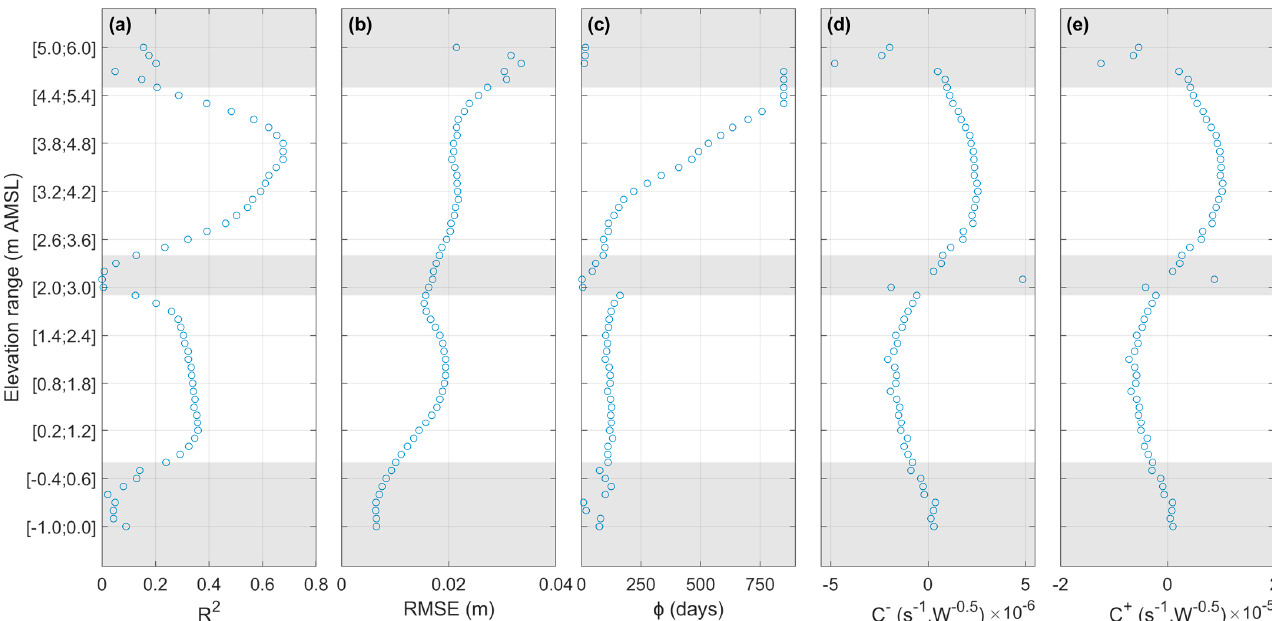
Figure 5. ( a ) R 2 and ( b ) RMSE between the observed and modeled beach slope and corresponding ( c ) Φ memory, ( d ) C − erosion rate coefficient and ( e ) C + accretion rate coefficient free parameters, found as a function of the elevation where the beach slope is computed. The shaded areas are where R 2 < 0.2 which we considered as elevations where beach slope does not show an equilibrium response.